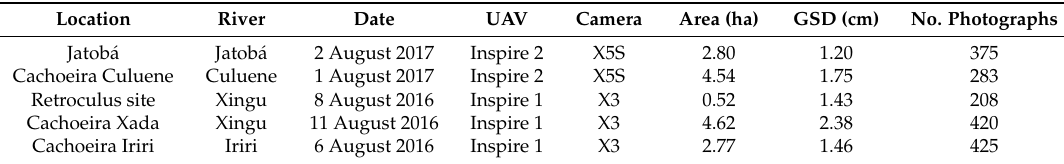
Table 2. Summary of UAV photographs collected for the study sites including the ground sampling distance (cm) of the densified 3D point cloud and the number of photographs used for creating the 3D